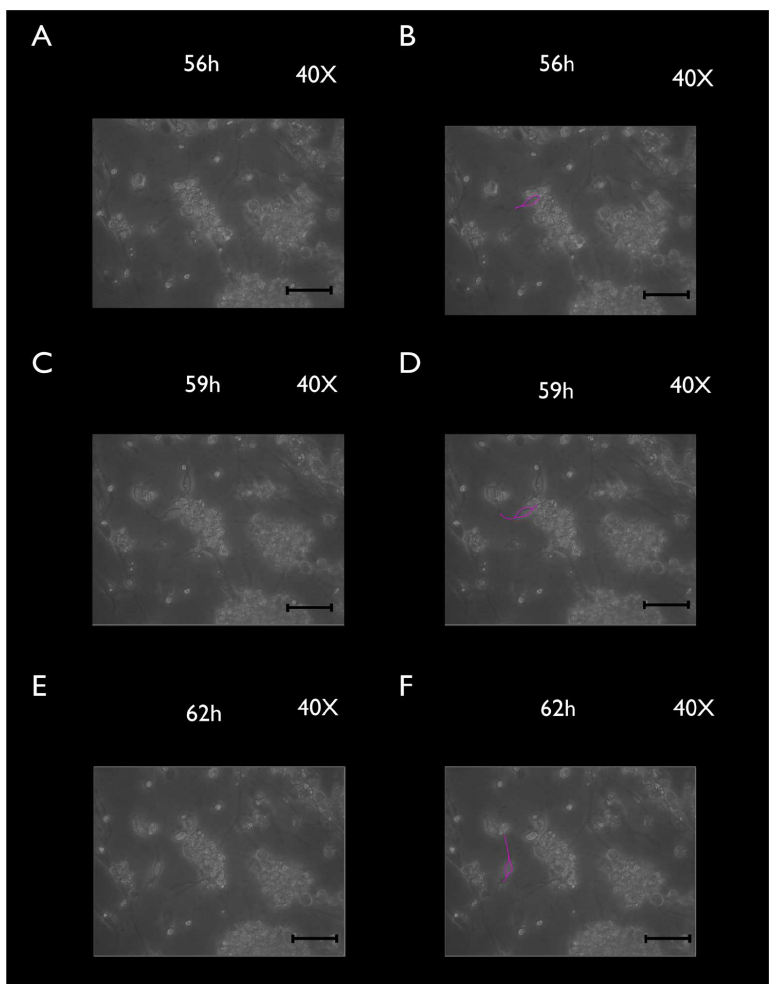
Figure 7. Time-lapse frames of cultured TGCs at 56, 59, and 62 h (40× magnification). SGCs continue to migrate away from neurons and develop a clear fusiform aspect ( A , C , E ). SGCs are highlighted (pink, B , D , F ). Scale bars represent 100 µm.